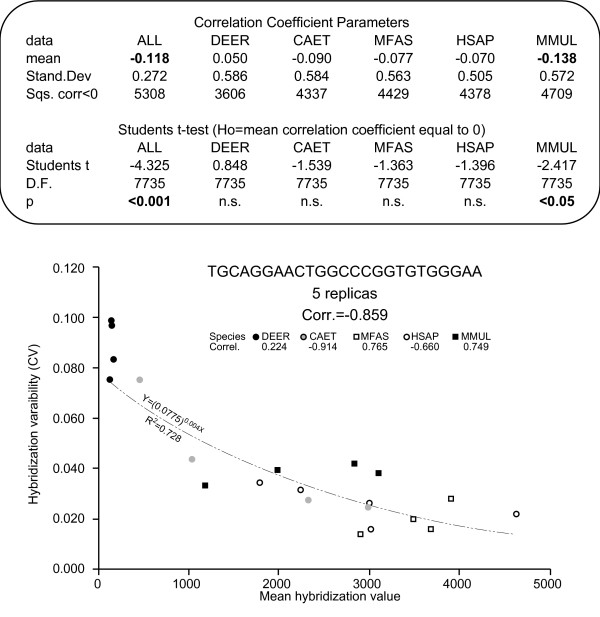
Correlation between mean hybridization value and CV value in the repeated sequences. Correlation coefficients were computed for each individual species and for all species together. The upper part of the table details the mean and standard deviation of the correlation coefficients of 7736 repeated sequences in each case. It also specifies the number of sequences with a negative correlation between mean and CV. Lower part of the table details the t-test parameters. The scatter plot below illustrates the correlation between mean hybridization value and CV value in a sequence repeated in 5 different probesets. It shows that correlation exists when all species are considered together but that it does not hold for the individual species.